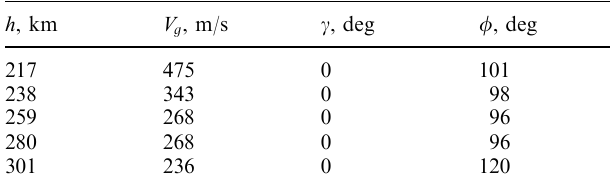
Table 2. TID group velocity ( V g ) and direction of motion ( (cid:99) elevation angle and (cid:47) azimuth) h , km V g , m/s